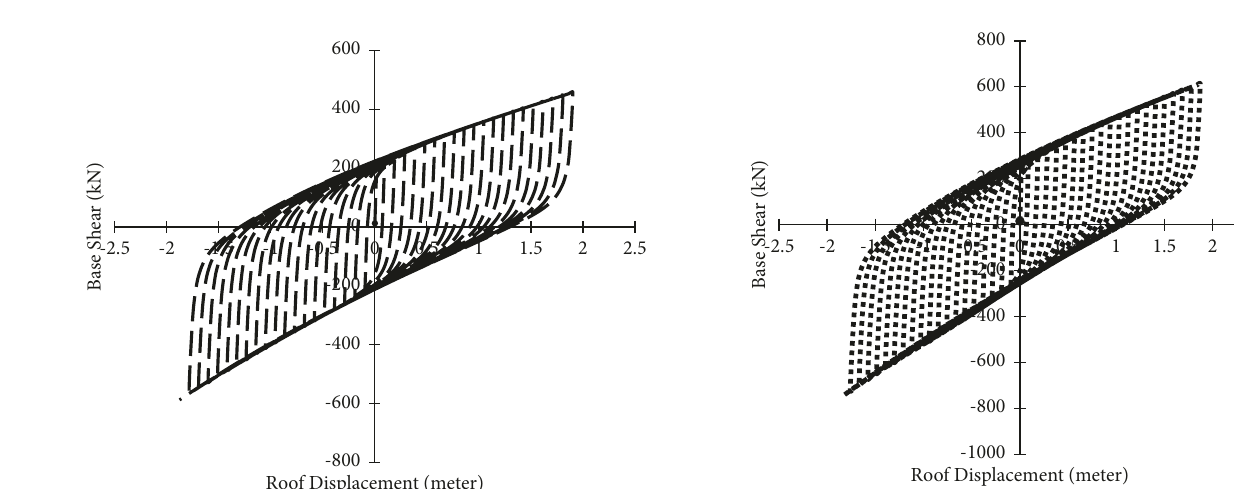
Figure 20: Steel-HSS braced portal frame hysteresis curve.